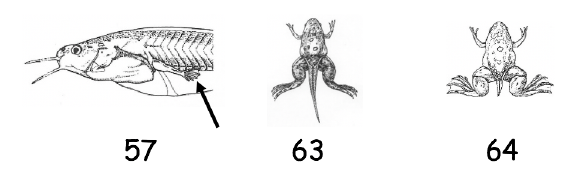
Figure A1. Tadpole development by stages. Hind limbs stage 57 denoted by ←−